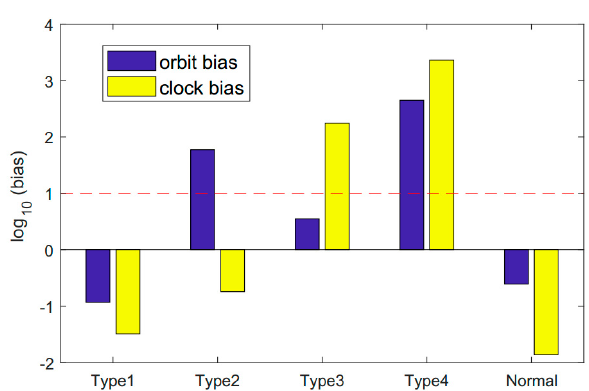
Figure 2. Orbit and clock biases between results calculated with the last healthy ephemeris and the first unhealthy one. Types 1, 2, 3, and 4 correspond to Sections 2.1–2.4, respectively. A normal case